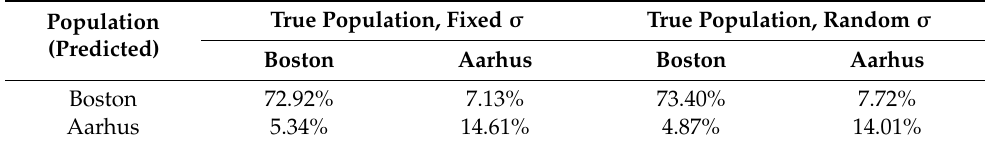
Table 3. We divided all the data points into four categories: true Boston, false Boston, true Aarhus and false Aarhus. The accuracy is the sum of both true classifications that is close to 90%. to 90%. Table 3. Classification accuracy for the univariate